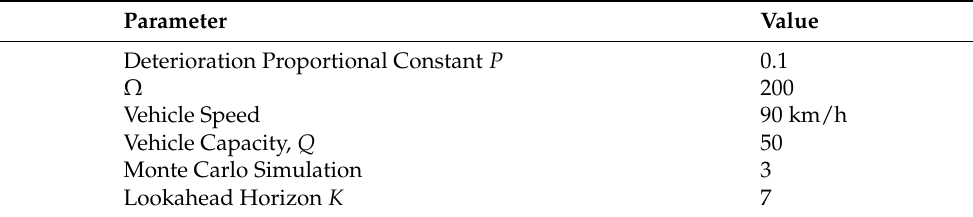
Table 4. Simulation and PDS-RA